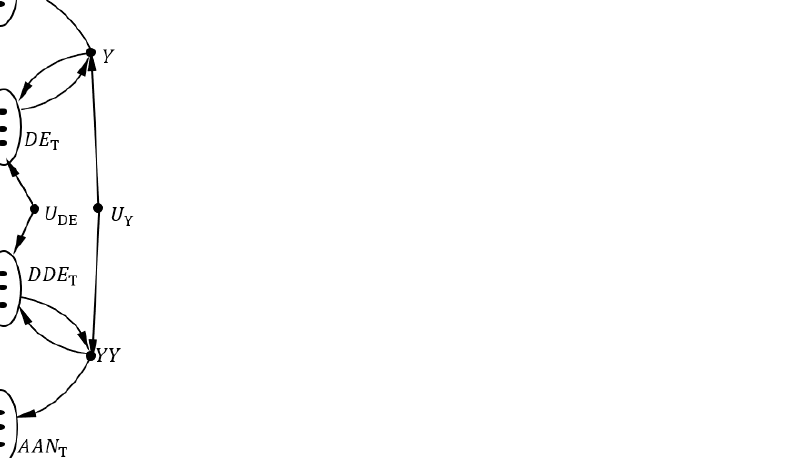
Figure 2. Twin network for counterfactual analysis when variable 𝑇 and variable 𝑌 have no com- mon